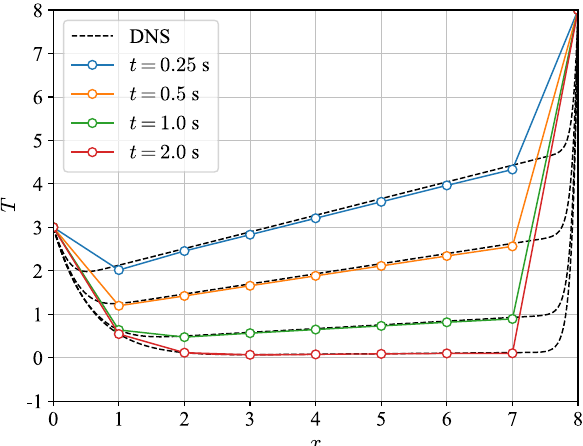
Fig. 11 A transient advective–diffusive–reactive problem. DNS solution is compared with the P-DNS solutions on the nodes of the coarse mesh. Times plotted are 0.25 s, 0.5 s, and 1s. Time step is (cid:5) t = 0 . 125 s and θ = 0 . 5